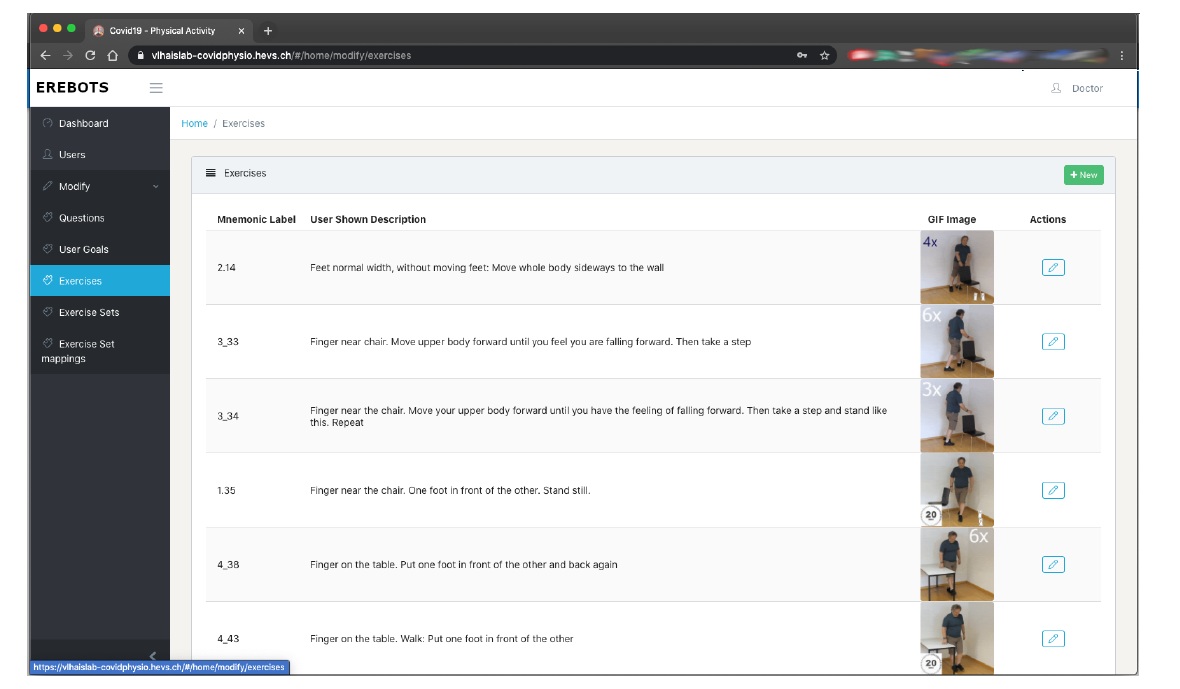
Figure 5. Schedule of the exercise sequence and upload of the related multimedia file. Concerning DF2, the physiotherapists and healthcare personnel are able to have a complete overview of the campaign and the general progress of the participants. More specifically, they have access to statistics, population composition in terms of gender, age group, language, physical advancement, etc. Figure 6 shows the dashboard visualizing synthetic data of a campaign managed by EREBOTS.